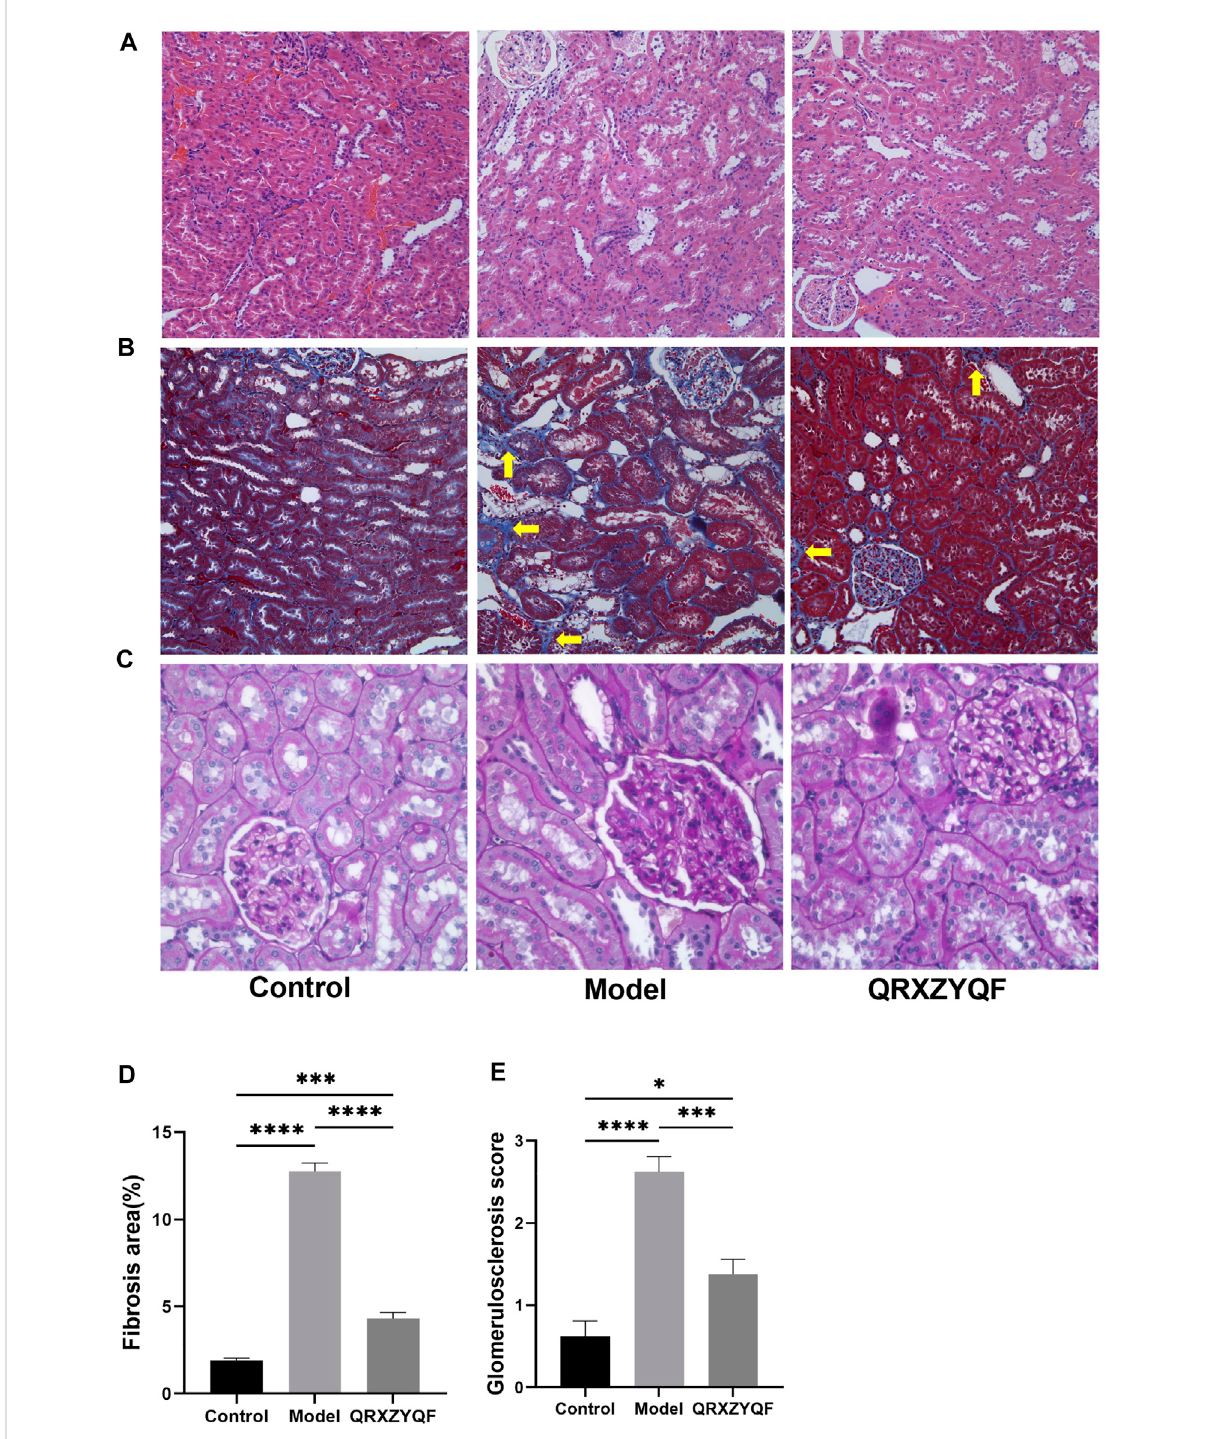
FIGURE 4 QRXZYQF treatment attenuated renal injury in DKD rats. (A) General morphological changes in different groups, HE staining (×200); (B) The levels of collagen deposition and interstitial lesions in different groups, yellow arrows indicated collagen deposition, Masson staining (×200); (C) Glomerulosclerosis levels in different groups, PAS staining (×400); (D) A semi-quantitative analysis for collagen areas according to Masson staining, dataareshownasmean±SEM,*** p < .001,**** p < .0001. (E) Asemi-quantitativeanalysisforthePAS-positiveglomerulosclerosisscoring;data are shown as mean ± SEM, * p < .05, *** p < .001, **** p <